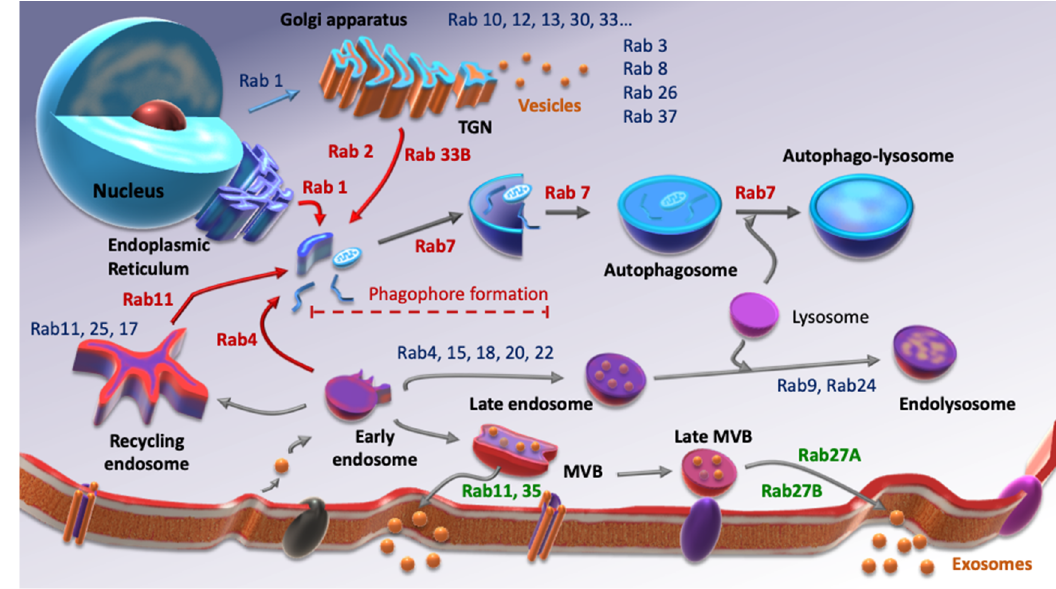
Figure 1. Screening of some Rab GTPases involved in autophagy (red), EVs secretion (green) and other Rab proteins involved in other cellular processes (blue). Inspired from [25,26].